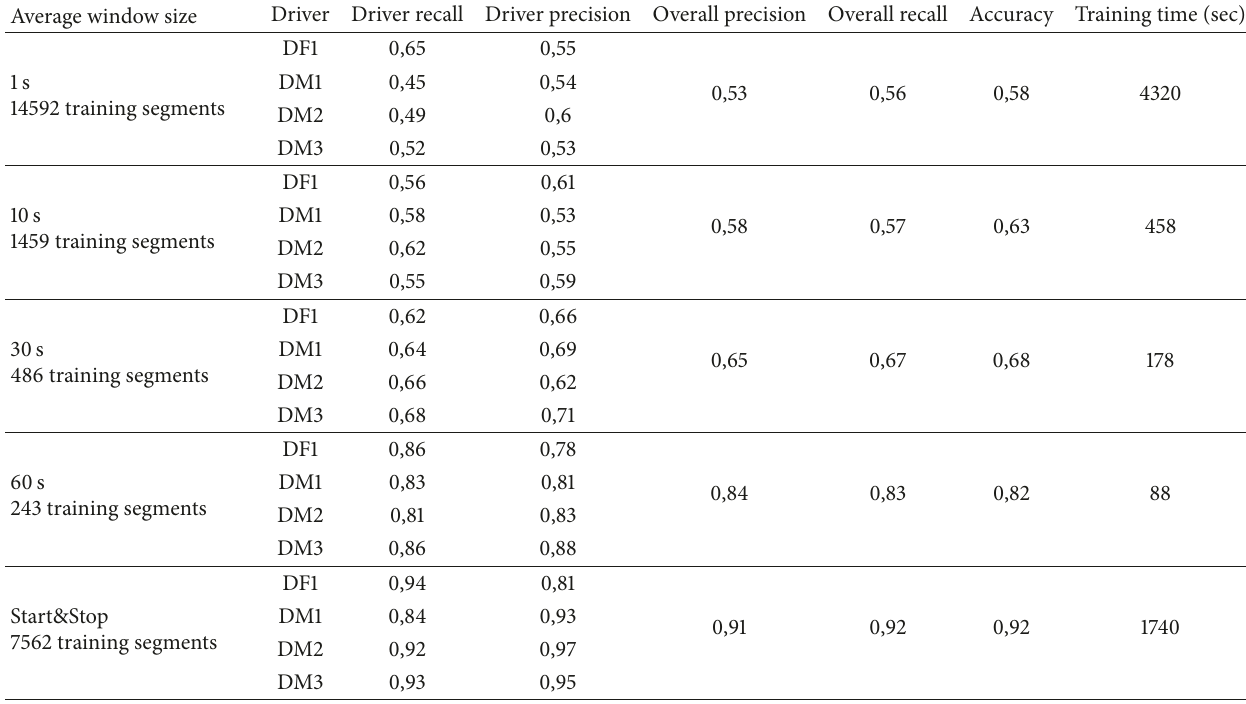
Table 6: 𝐸 13 , precision, recall, accuracy, and training time evaluated by using MLP for different windows sizes. Average window size